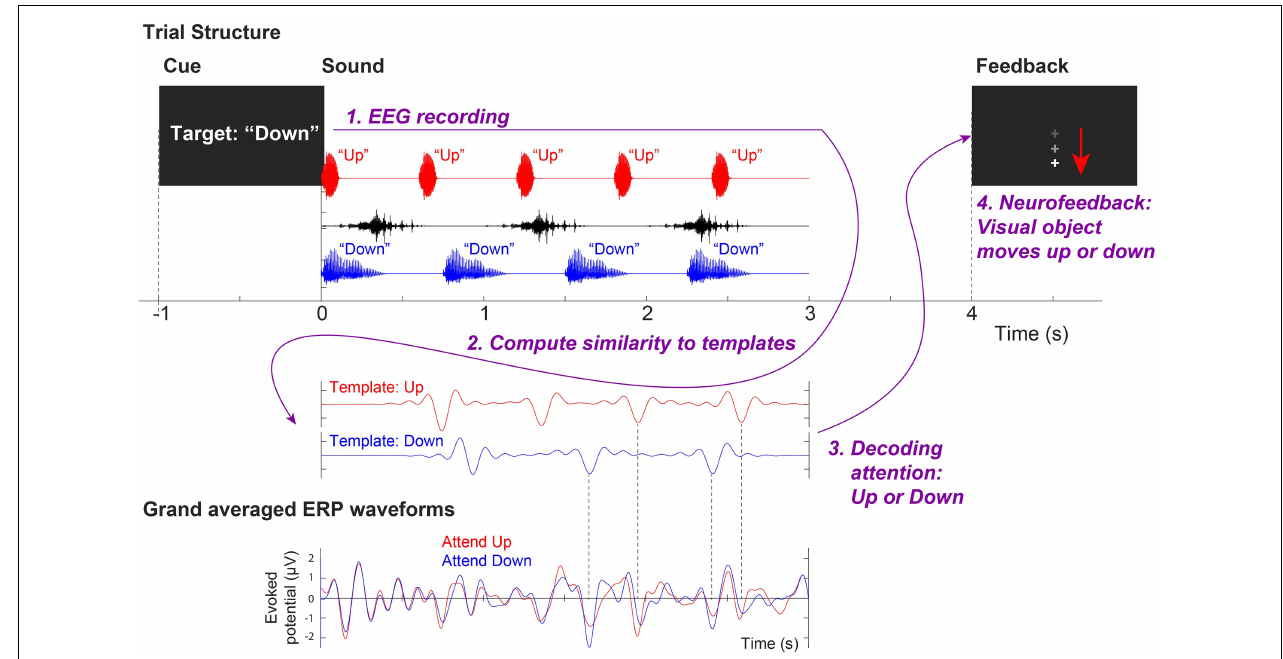
FIGURE 1 | Trial structure of the neurofeedback training assigned to the Experimental Group. This example shows an attend- down trial.